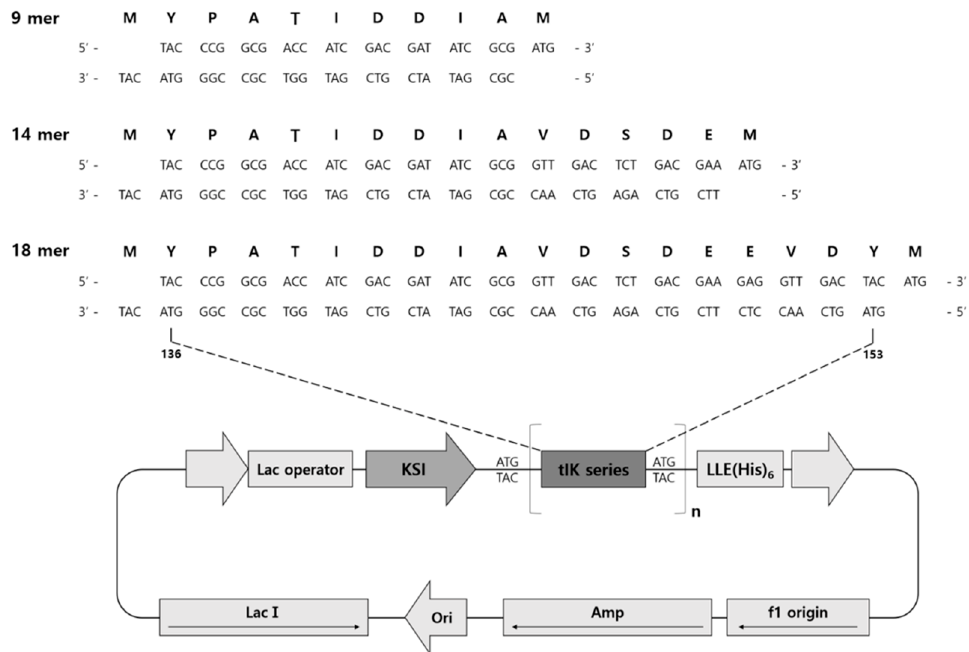
Figure 4. Schematic representation of the ketosteroid isomerase (KSI)-fused expression vector for the tIK series (9-mer, 14-mer, 18-mer). A commercial vector, pET31b (+), was used, and the DNA and amino acid sequences of the inserts are shown on the vector map. The tIK series was expressed as a fusion protein consisting of KSI (ketosteroid isomerase) to make it hydrophobic and a His 6 -tag was added for purification.